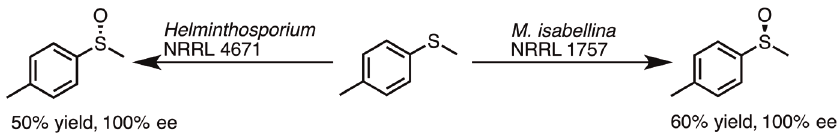
Figure 6 - Production of optical pure sulfoxides with different